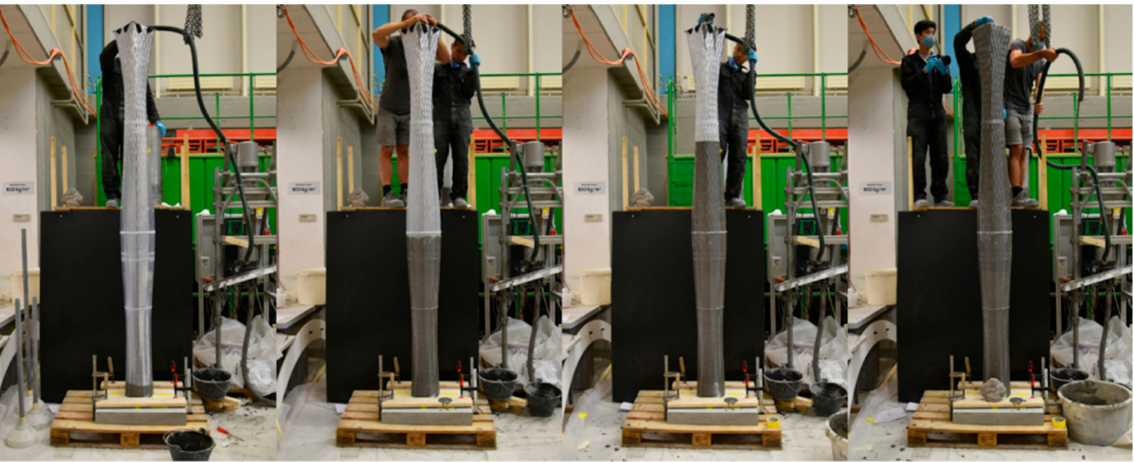
Figure 12. Casting process with DCS with the eggshell formwork.